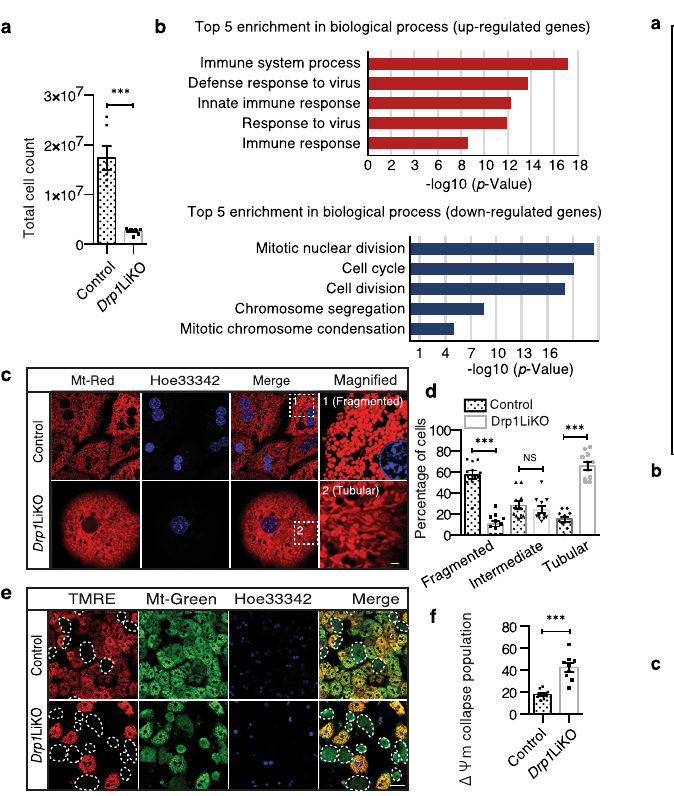
Fig. 5 Microarray functional annotation analysis, mitochondrial morphology, and mitochondrial membrane potential ( ΔΨ m ) in control